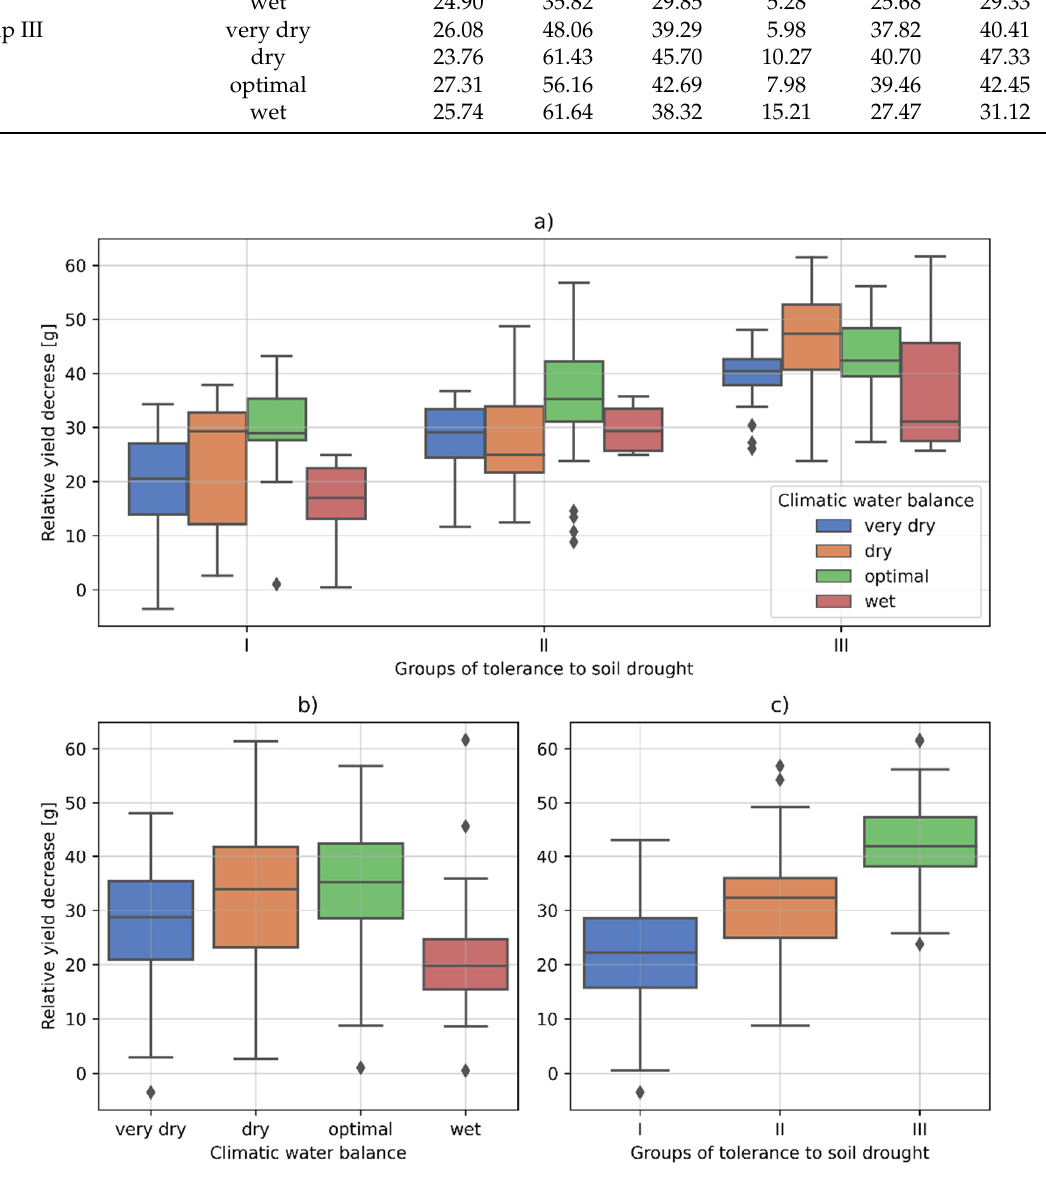
Figure 2. Relative yield decrease in years ( a ) according to the climatic water balance: very dry, dry, normal, and wet; ( b ) for different cultivar groups with a tolerance to soil drought; and ( c ) both splits simultaneously. Table 3. Descriptive statistics for the measured relative yield decrease concerning: (a) climatic water balance classes, (b) decrease for cultivar groups of tolerance to soil drought, and (c) for cultivar groups of tolerance to soil drought and climatic water balance classes.